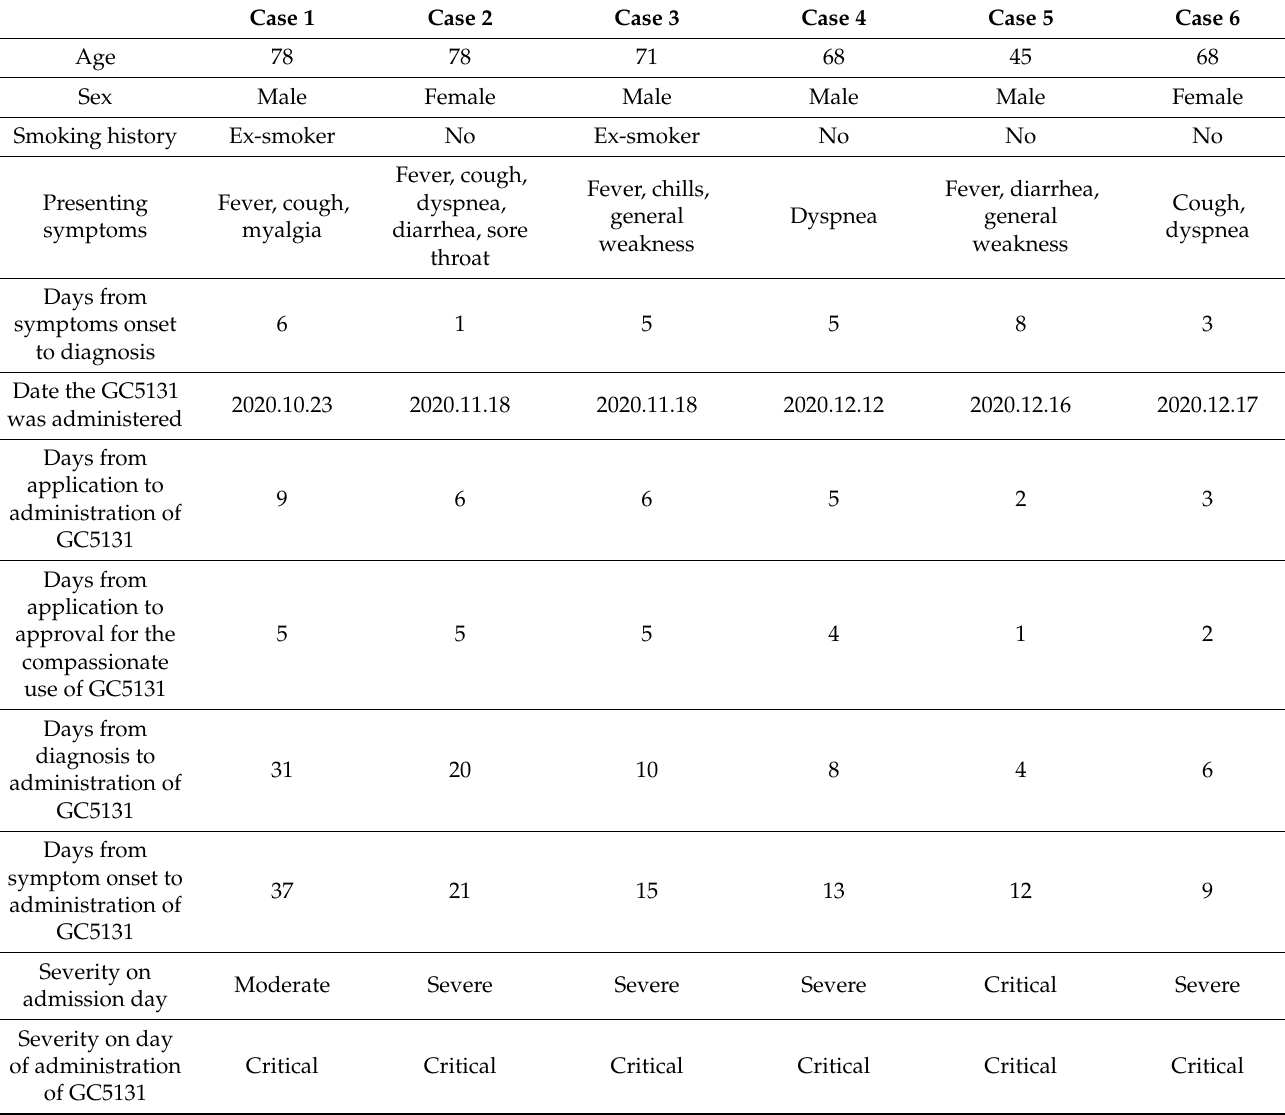
Table 1. Clinical characteristics of patients diagnosed with COVID-19 who underwent the GC5131 therapy. Case 1 Case 2 Case